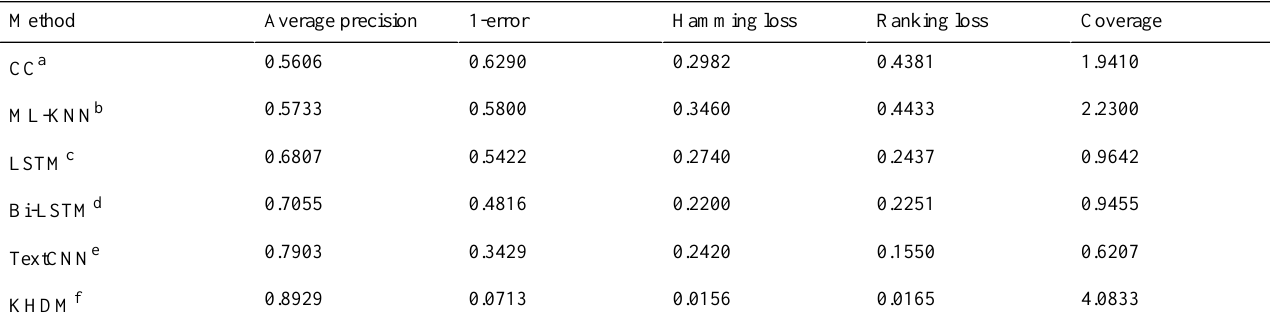
Table 4. Comparative results on public dataset Hep